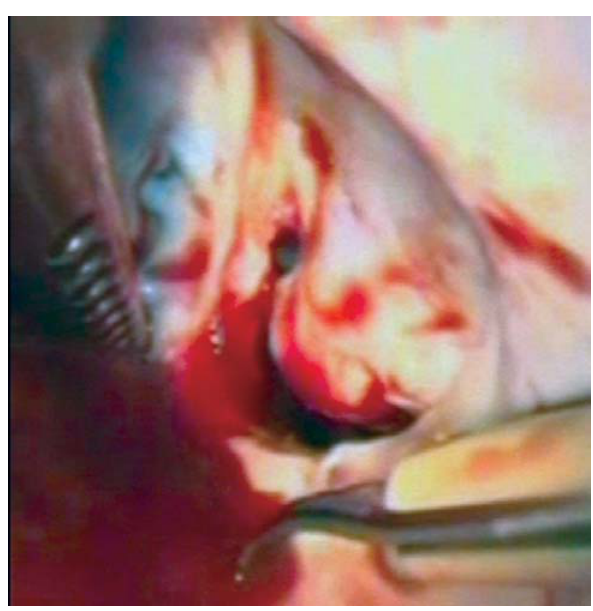
Fig. 3 - Aspecto pré-operatório da valva mitral, demonstrando estenose crítica